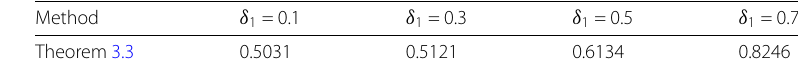
Table 6 The maximum allowable values of δ 2 for different values of δ 1 in Example 4.5